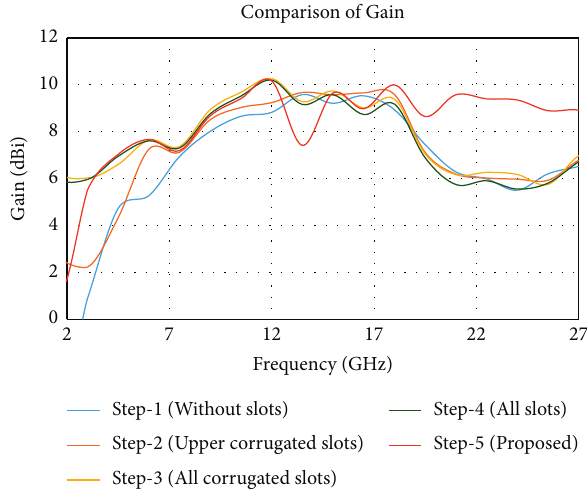
Figure 3: Gain curve for different evolution stages.